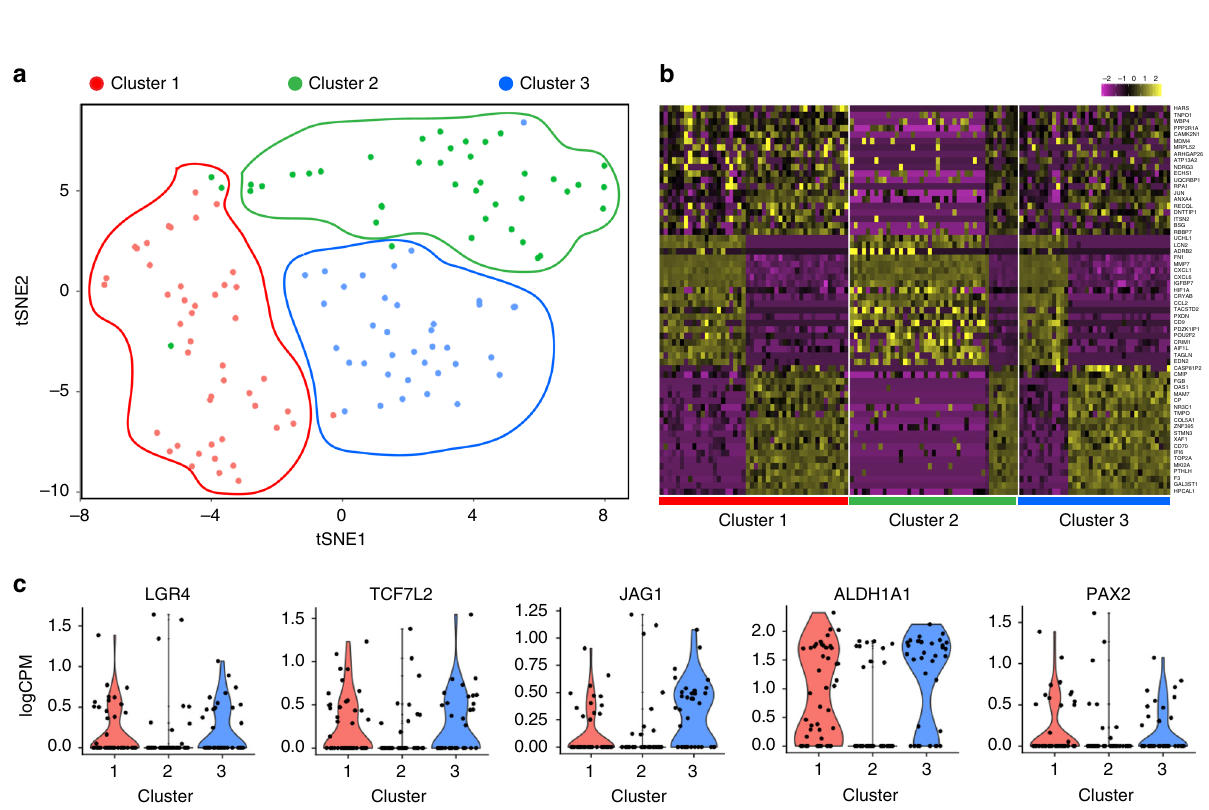
Fig. 4 Activation of WNT in NOTCH signaling in CXCR4 + MET + CD44 + and spheres. Microarray analysis of spheres, FAC-sorted CXCR4 + MET + CD44 + and control cells from three ccRCCs. a Heatmap and hierarchical clustering of the 500 most variable probes. b log2 fold changes of top-scoring genes associated with the GO terms kidney development, stem cell maintenance, WNT and NOTCH signaling. Data are shown as mean, error bars represent s.d. ( n = 3 patients). c , d WNT or NOTCH luciferase reporter gene assays of sphere and adherent cultures of ccRCC ( n = 5 independent patients). Data are shown as mean, error bars represent s.d., p -values calculated by two-sided t -test. e , f siRNA knockdown of CTNNB1 or NOTCH1 in spheres ( n = 5 patients). Data are shown as mean, error bars represent s.d., p -values calculated by two-sided t -test. g , h ELISA for WNT10A and WNT7B secretion of adherent, organoid and sphere cultures ( n = 6 patients). Supernatants were collected after 7 days of culture. Values were normalized to the number of cells per ml medium and are represented as ng protein per 10 6 cells. Line represents mean protein concentration and error bars show the s.d. p -values: *<0.05, ***<0.001 by RM ANOVA with Dunnett ’ s post-test (two-sided). i , j WNT or NOTCH luciferase reporter gene assays of sphere cultures ( n = 5 independent patients) transfected with a β -Catenin-LEF1 fusion protein encoding plasmid. Data are shown as mean, error bars represent s.d., p -values calculated by two- sided t -test. k Expression of WNT and NOTCH pathway genes measured by RT-qPCR in β -Catenin-LEF1-transfected spheres ( n = 5 patients). Data are shown as mean, error bars represent s.d., p -values: **<0.01, ***<0.001, ****<0.0001 by two-sided, paired t -test. Overall survival of TCGA KIRC specimens with or without the stem cell signature ( l ), the WNT and NOTCH signature ( m ), or high (>median) or low (<median) DKK3 ( n ) or NOTCH3 expression ( o ). Stem cell signature predictor score was calculated by multivariate Cox regression, patients were strati fi ed into groups according to the median predictor score. Censored patients are presented as vertical lines. Signi fi cance was tested by log rank test (two-sided).